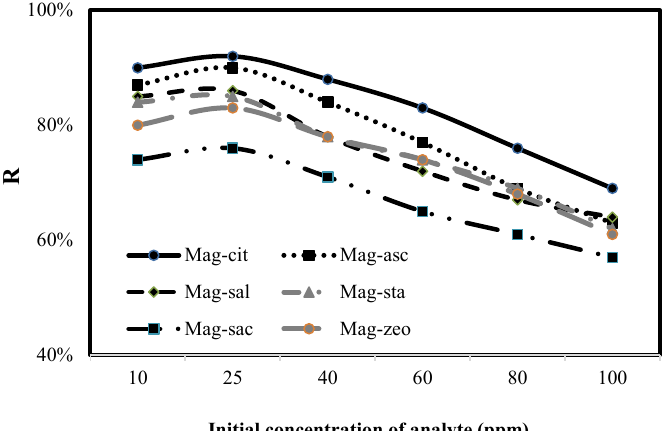
Fig. 13. Initial concentration effect on removal of